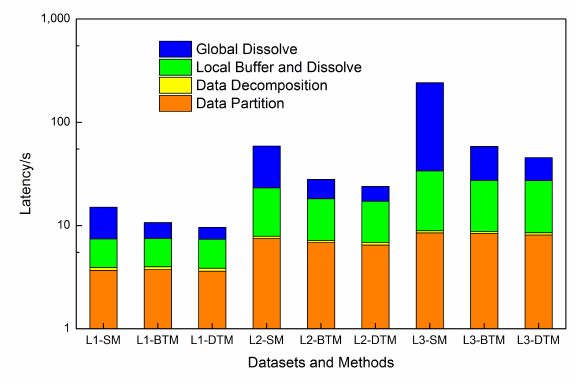
Figure 10. Experiments on the tree-like merger methods.